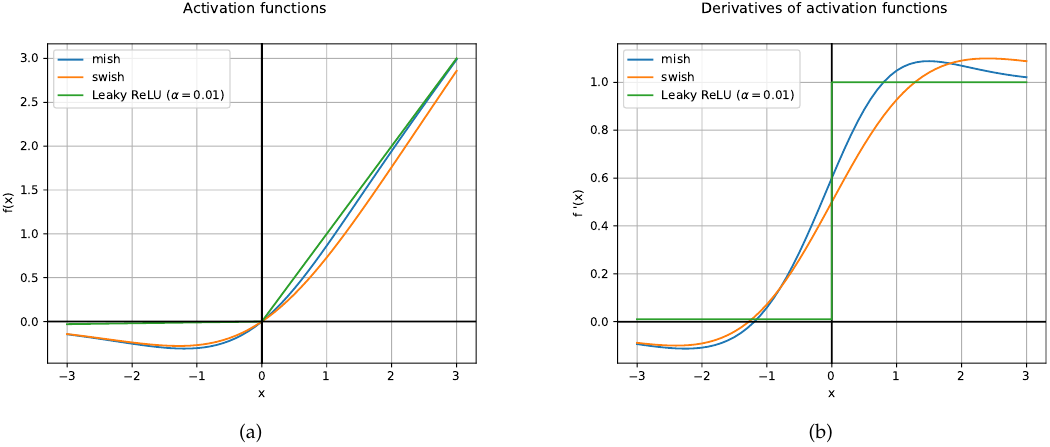
Figure 4. Leaky ReLU, MISH, and SWISH activation functions ( a ) and their derivatives ( b ).